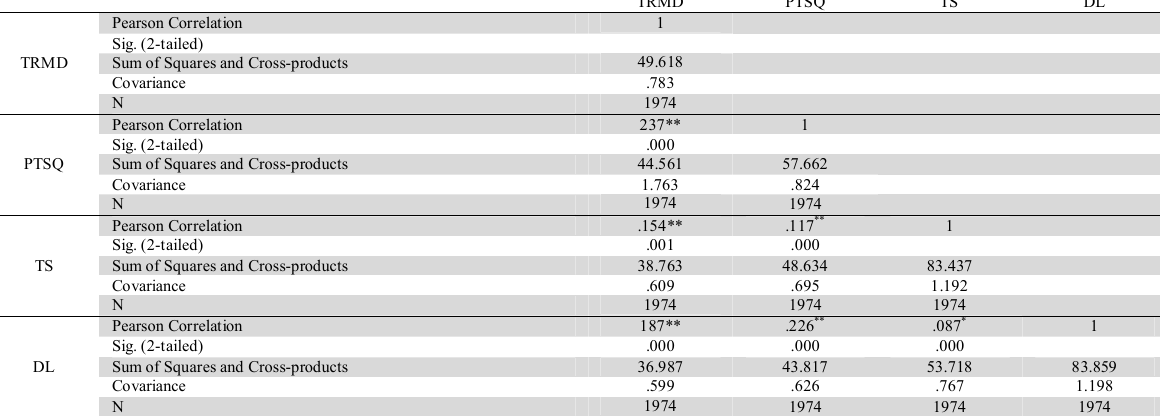
Bivariate correlation between perceived tourist service quality (PTSQ), tourist satisfaction (TS) and destination loyalty